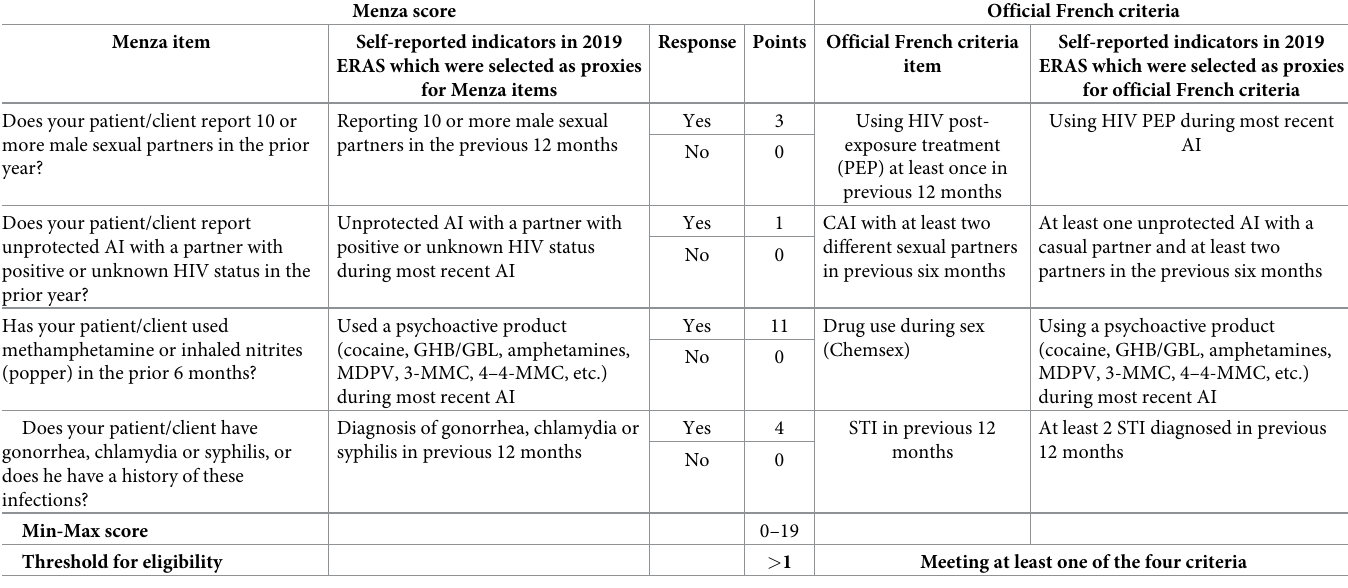
Table 1. Menza score items and official French